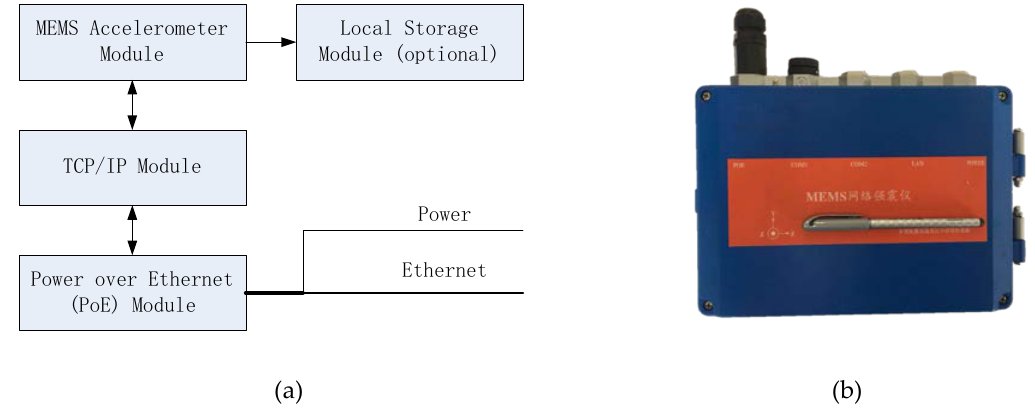
Figure 1. Composition and appearance of the low-cost seismic sensor: ( a ) Depiction of the sensor’s hardware modules; ( b ) Depiction of the sensor’s real appearance.